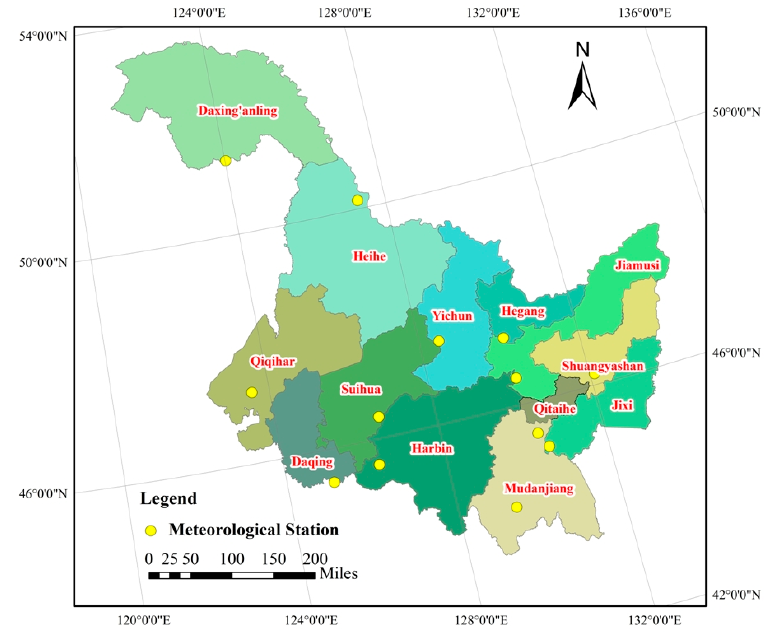
Figure 1. The location of Heilongjiang Province in